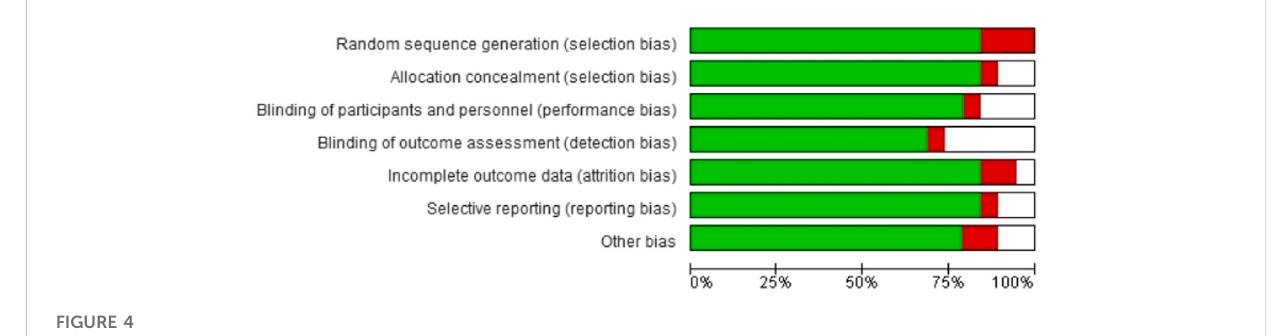
FIGURE 4 The overall risk of bias in included